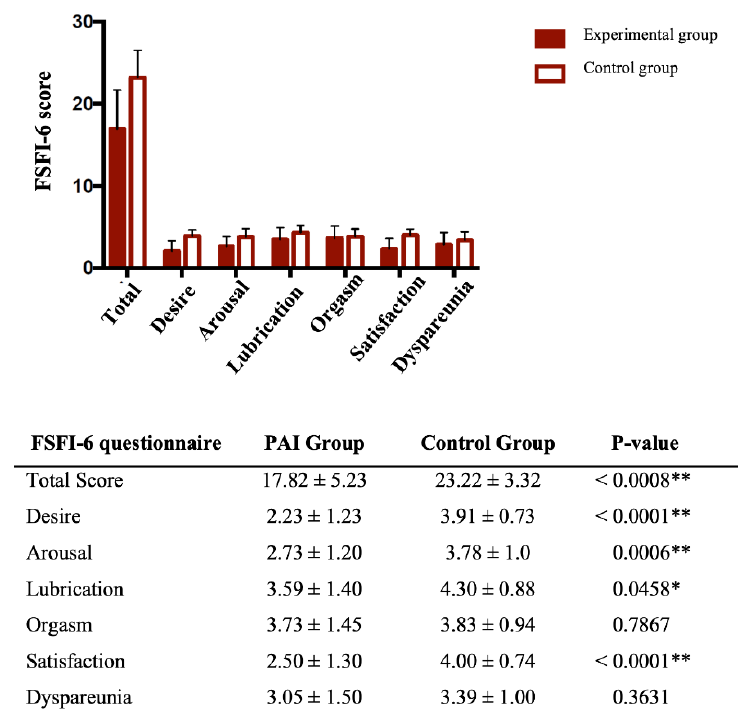
Figure 1. The graph bars represent total score and single items (mean ± SD) of FSFI-6 in the primary adrenal insufficiency (PAI) group and the control group. In the table below, the same value of total score and single items (mean ± SD) of patients and controls are displayed together with p values (Unpaired t tests, Mann–Whitney tests) (** p < 0.001; * p < 0.01).